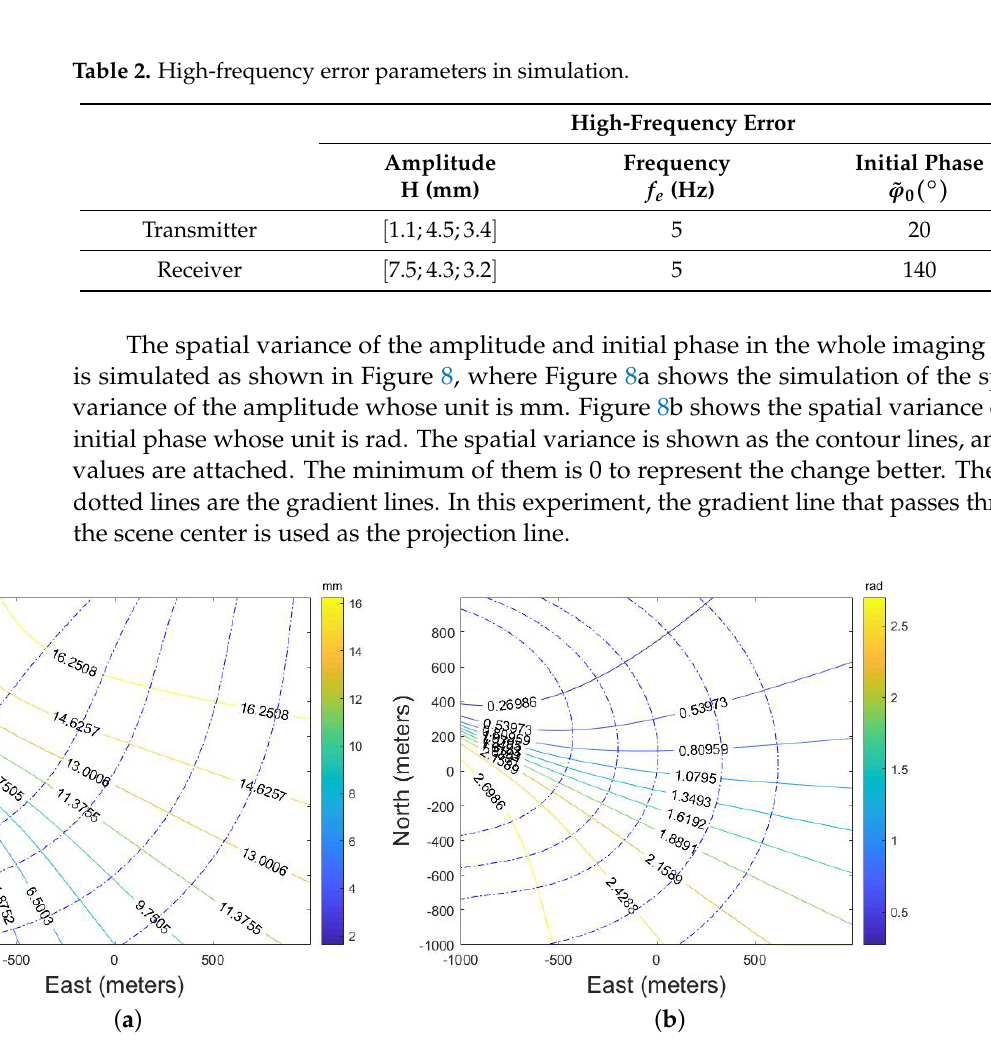
Figure 8. The bistatic spatial variance of the amplitude and initial phase under simulation. ( a ) is the result of amplitude. ( b ) is the result of the initial phase. The contour lines are shown as solid lines with values attached and the gradient lines are shown as blue dotted lines.